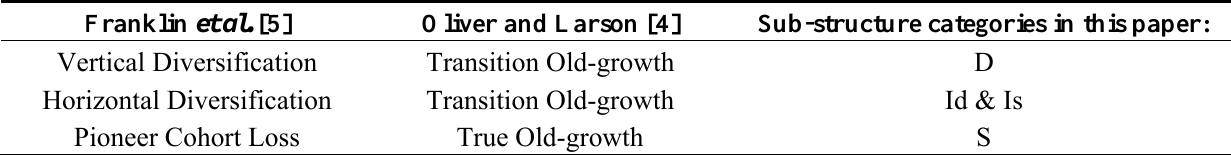
Table 5. Comparison of “old-growth” substructures suggested by Franklin et al. [5] and Oliver and Larson